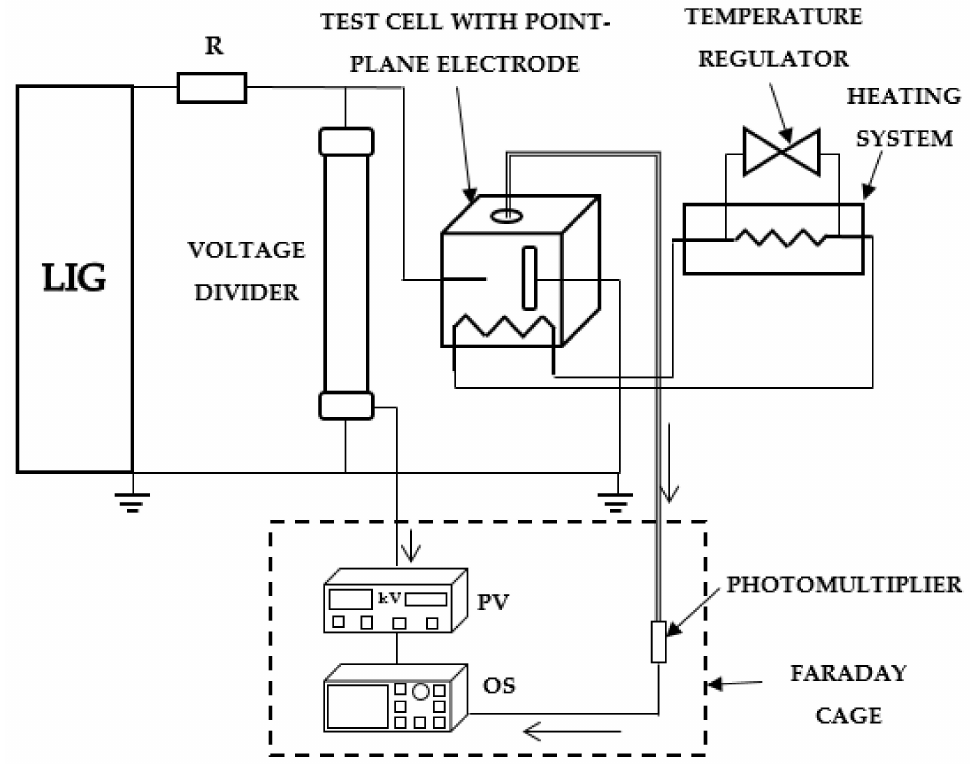
Figure 3. Experimental setup: LIG, lightning impulse generator; R, limiting resistor; PV, peak value meter; OS,